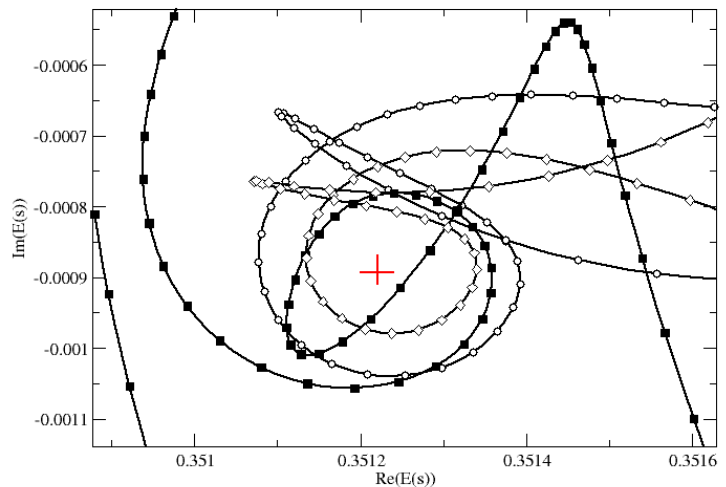
Figure 6. CAP-trajectories in the vicinity of the lowest 1 S 0 resonance of H − for the different values of the scaling factor λ (26), i.e., ○ —λ = 1.3, □—λ = 1.5, ◊—λ = 1.7. Sign + indicates the position of the resonance [48]. Data are presented in a.u.